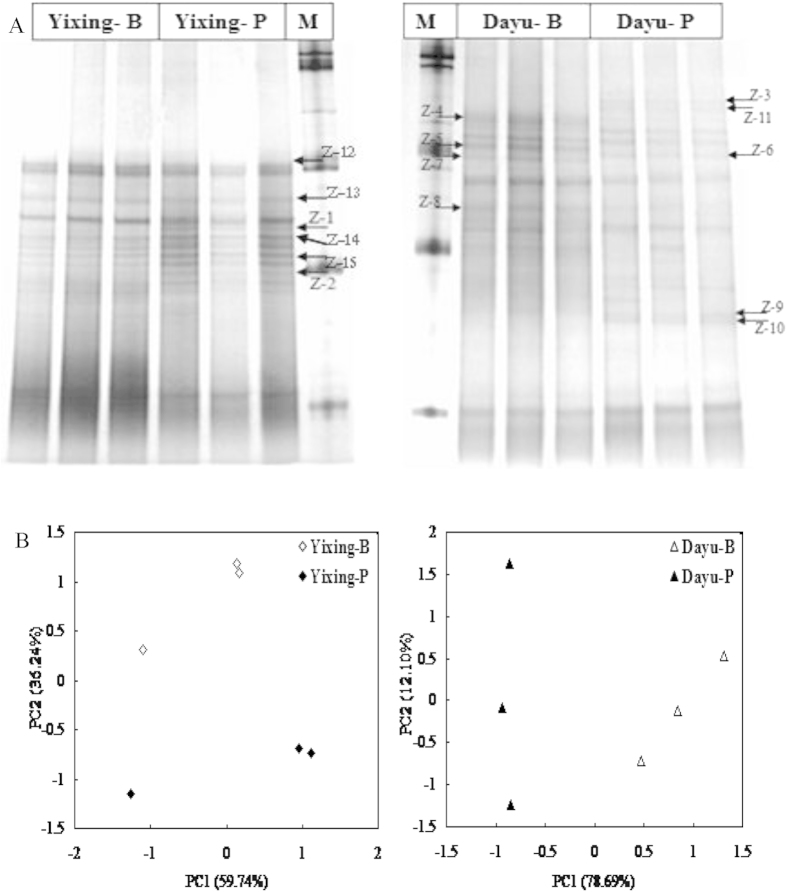
DGGE profiles (A) and principal component analysis (B) of nosZ gene fragment from the background and polluted soils in Yixing and Dayu. M: 100 bp Marker. Arrows indicate the excised bands (Z1–Z15) for sequencing. Similar symbols in PCA plot indicate the replicate samples.